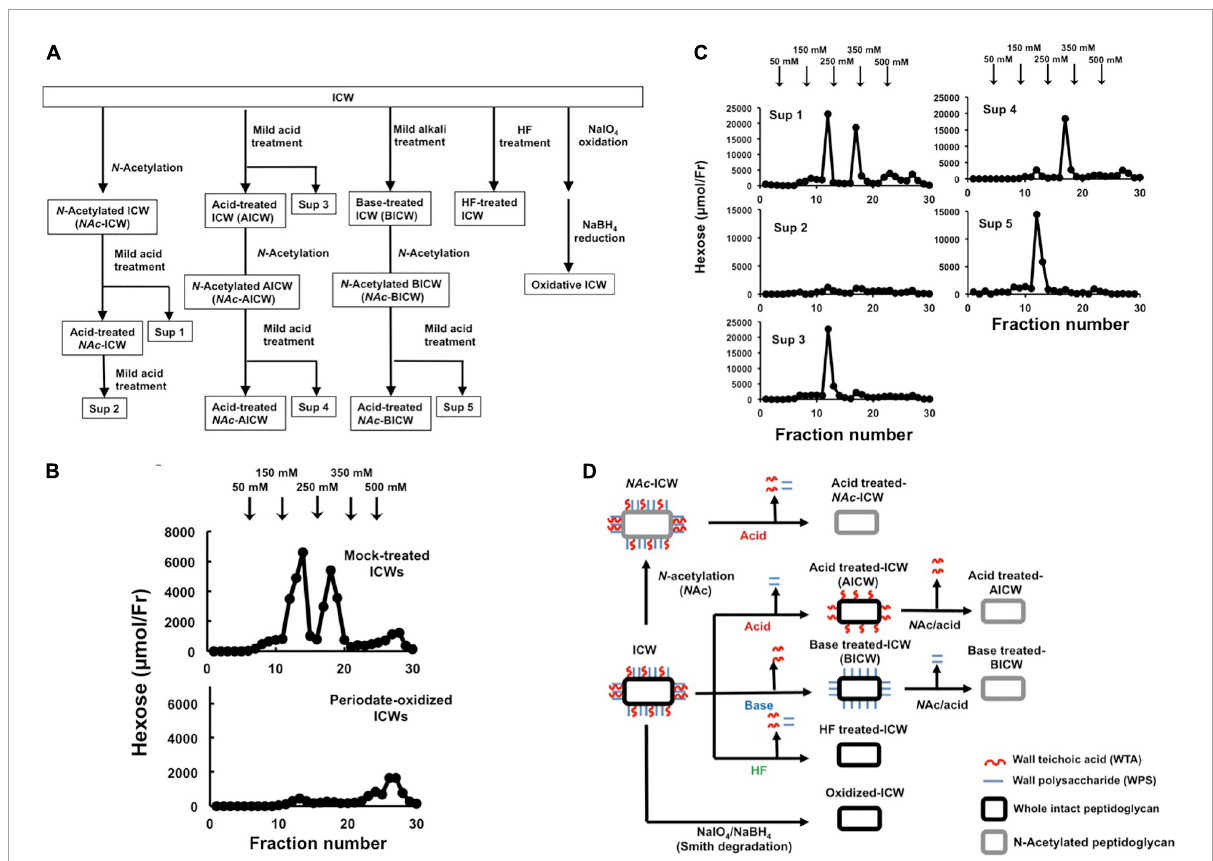
FIGURE4 Chemical modification of ICWs of L. plantarum TUA 5099L. (A) Flowchart of treatments of ICWs with mild acid (0.1 M glycine-HCl, pH 2.5, 100 ◦ C, 30 min), mild base (0.5 M NaOH, 37 ◦ C, 30 min), aqueous hydrogen fluoride (47% HF, 4 ◦ C, 16 h), and periodate (0.1 M NaIO 4 , pH 4.5, 4 ◦ C 48 h). (B) Smith degradation of ICWs. Periodate-oxidized ICWs and mock-treated ICWs were hydrolyzed with 0.1 M glycine-HCl, pH 2.5, 100 ◦ C for 30 min after N -acetylation, and each resulting supernatant was subjected to chromatography on a DEAE-cellulose column (described